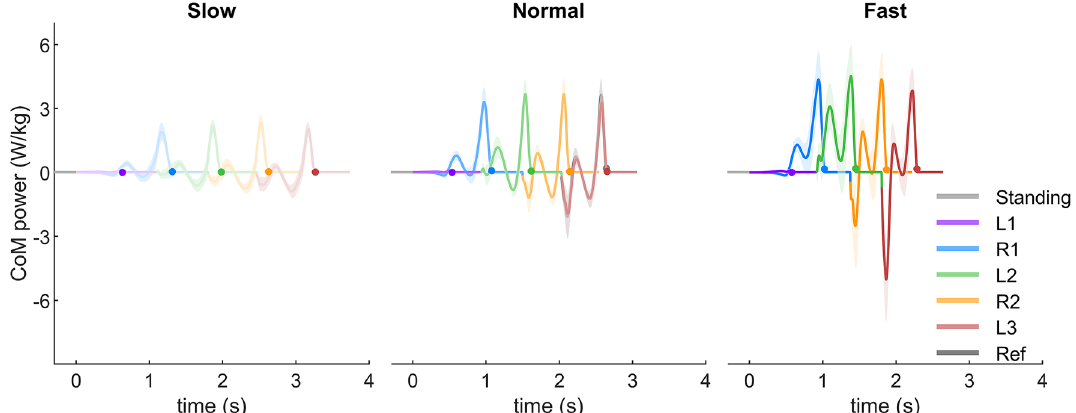
Figure 7. The CoM mechanical power of slow, normal and fast gait initiation. Solid lines denote the mean value over 23 subjects. Time 0 is defined as the beginning of the gait initiation. Ref denotes the regular overground walking at self-selected velocity. The error bands denote ± 1 standard deviation. Different colors denote different strides. L1, L2, L3 denote the first, second, and third stride on the left side, respectively. R1 and R2 denote the first and second stride on the right side, respectively. The dots denote the take-off